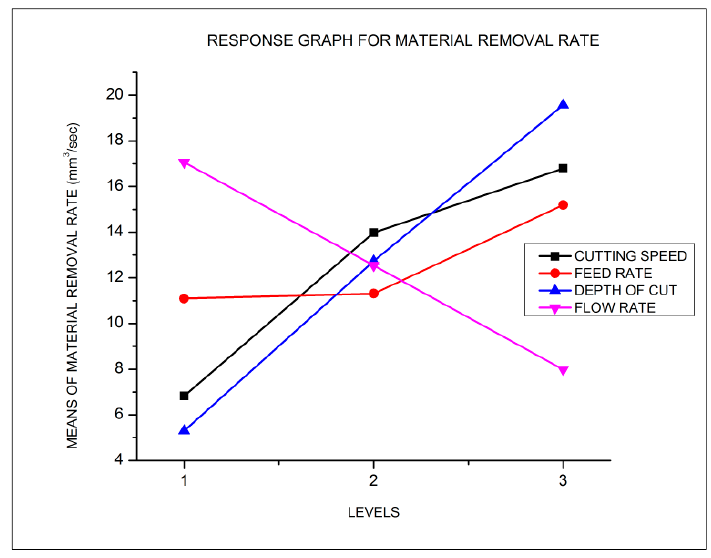
Figure 3. Analysis on material removal rate.